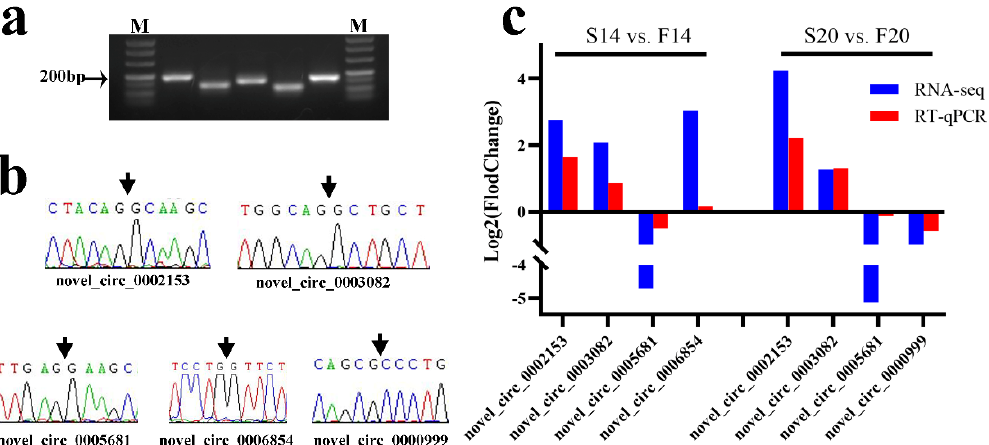
Figure 6. Validation of differentially expressed circRNAs with RNA-seq. ( a ) Agarose gel electrophoresis results for PCR products of divergent primers with cDNA; M: Maker. The electrophoretic bands from left to right are novel_circ_0002153, novel_circ_0003082, novel_circ_0005681, novel_circ_0006854, and novel_circ_0000999. ( b ) Sanger sequencing results for the back-splicing junction of circRNAs. ( c ) RT-qPCR validation of five differentially expressed circRNAs in S14 vs. F14 and S20 vs. F20, respectively. NOTE: Original gel for Figure 6a is presented in Supplementary Figure S2.